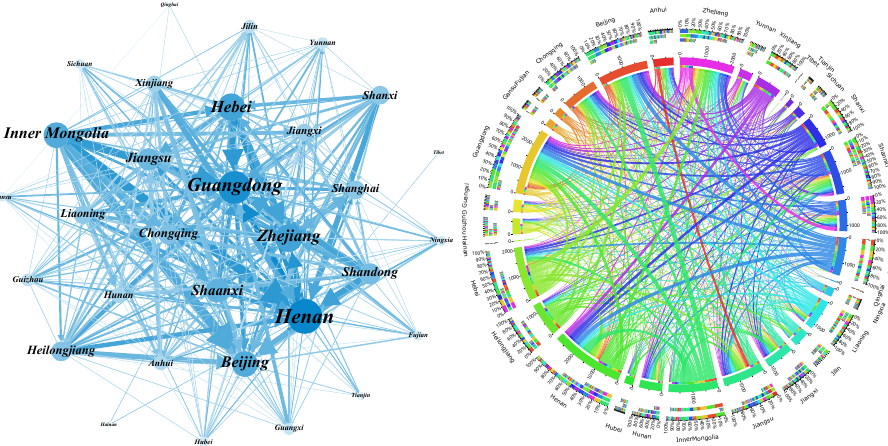
Figure 7. Inter-provincial embodied carbon emission transfers in 2017. We calculate the structural characteristic indicators of the ECETN corresponding to the three years using complex network theory, and the obtained results are shown in Table 2. As density decreases, the network becomes sparse. During the study period, the average shortest path decreases from 1.590 to 1.586 and then decreases to 1.560 in 2017,